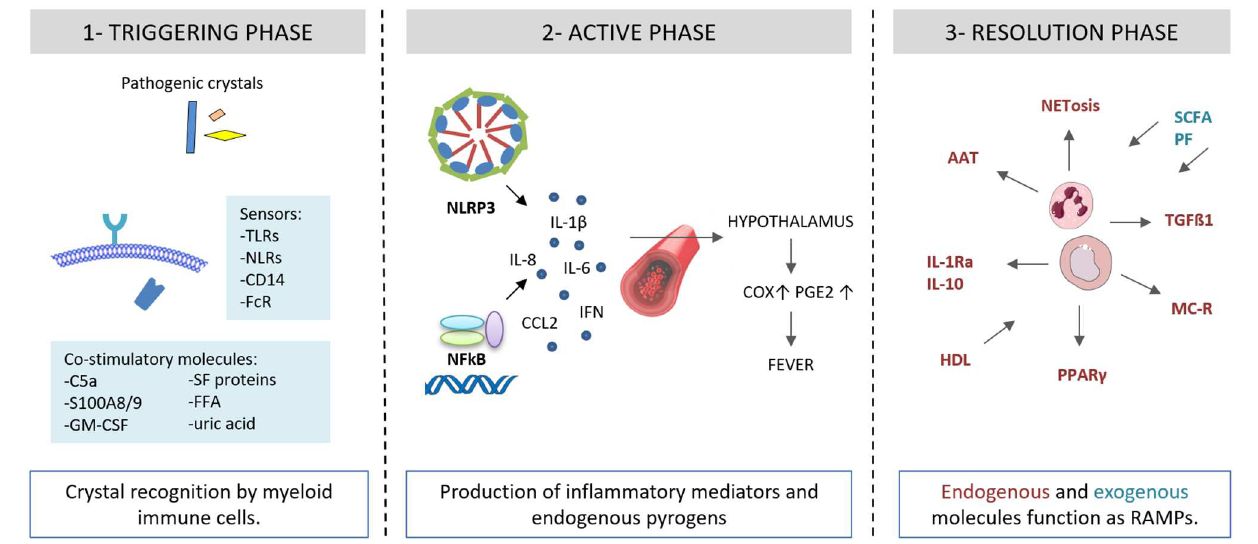
FIGURE 2 | Autoinflammatory steps in crystal-induced inflammation. (1) Crystal deposition triggers the acute attack in presence of co-stimulatory molecules (C5a, S100A8/A9, GM-CSF, SF proteins, FFA, uric acid). Innate immune system receptors (TLRs, NLRs, CD14, FcR) recognize pathogenic crystals promoting acute inflammatory responses in myeloid cells (monocytes/macrophages). (2) Through NLRP3 activation, crystals induce the production of IL-1 β and inflammatory mediators and endogenous pyrogens. (3) Endogenous and exogenous molecules function as RAMPs and limit the inflammatory response. AAT, alpha-1-anti-trypsin; C5a, complement factor 5a; CCL2, C-C motif chemokine ligand 2; COX, cycloxygenase; FcR, Fc receptor; GM-CSF, granulocyte-macrophage colony-stimulating factor; granulocyte HDL, high density lipoproteins; IL, interleukin; IL-1Ra, IL-1 receptor antagonist; IFN, interferon; FFA, free fatty acids; NET, neutrophil